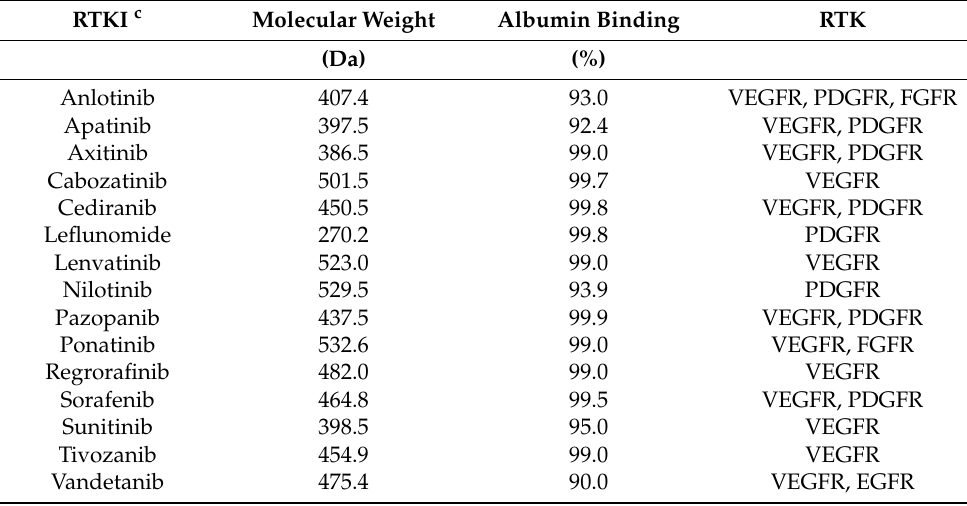
Table 1. Small molecule anti-angiogenics used in cancer therapy a,b,c . RTKI